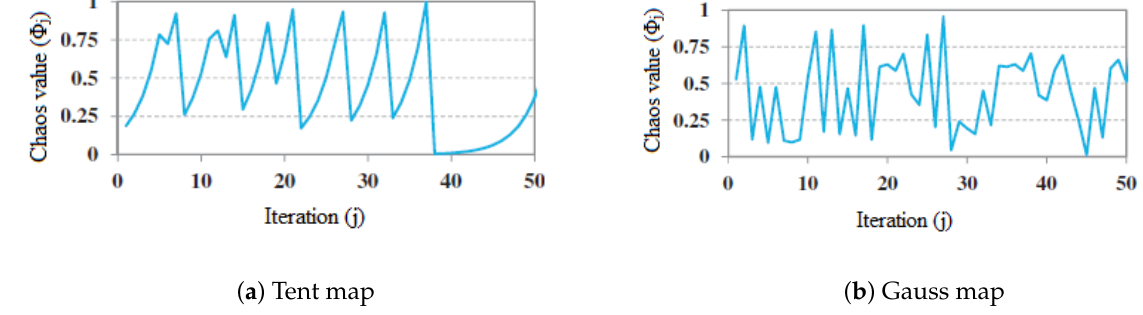
Figure 1. Time series plot of the tent and Gauss maps, respectively